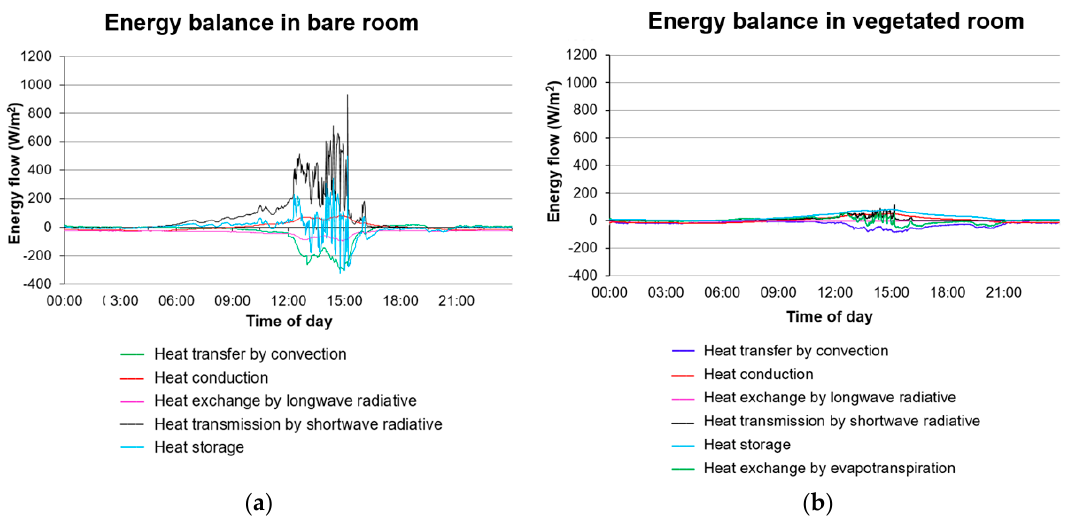
Figure 9. Comparison of heat exchange between ( a ) The bare room and ( b ) The vegetated room on a sunny day 30 August 2017.